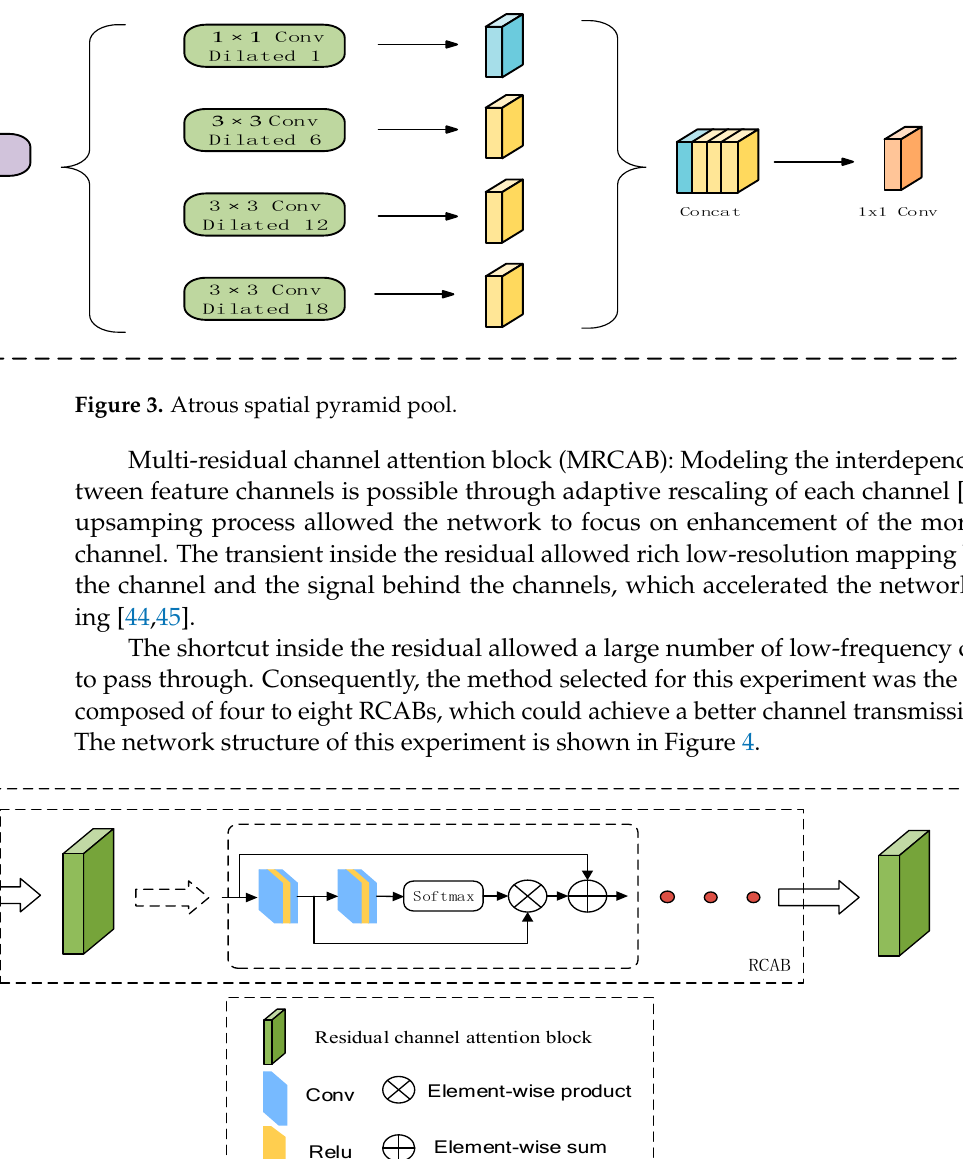
Figure 2. Receptive field block.